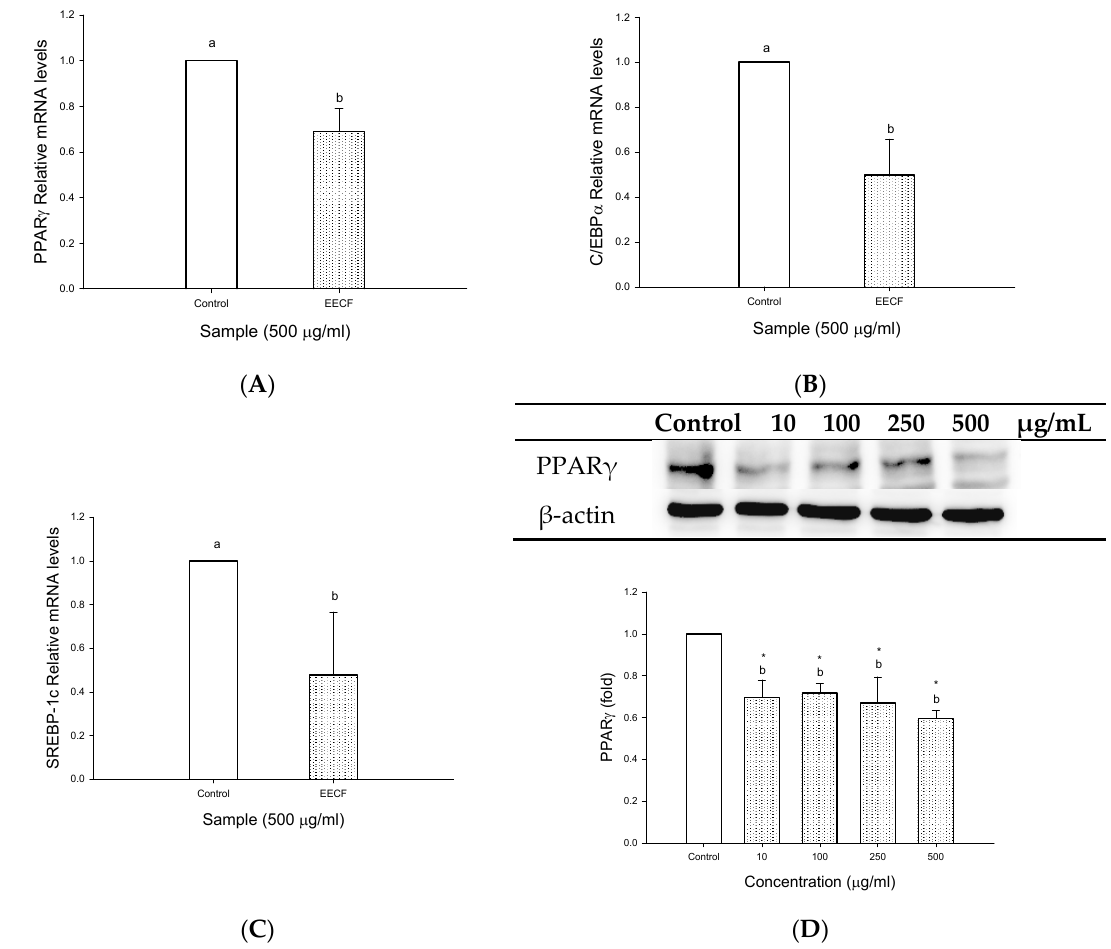
Figure 2. Effect of ethanol extracts of Djulis (EECF) on expression of adipogenic genes in 3T3-L1 adipoctyes. ( A ) The effect of EECF on gene levels of PPAR γ in 3T3-L1 cells. The cells were incubated with EECF for 6 h. ( B ) The effect of EECF on gene levels of C/EBP α in 3T3-L1 cells. The cells were incubated with EECF for 12 h. ( C ) The effect of EECF on gene levels of SREBP-1c in 3T3-L1 cells. The cells were incubated with EECF for 12 h. ( D ) The effect of EECF on PPAR γ protein expression in 3T3-L1 cells. The cells were incubated with EECF for 18 h. Data are expressed as the mean ± SD of three independent experiments. * ( p < 0.05), compared to the control. Values in each concentration with different superscript letters are significantly different ( p < 0.05).